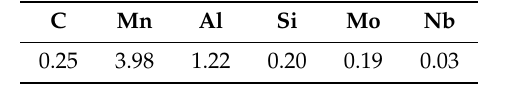
Table 1. Chemical compositions of the investigated steel (wt.%)